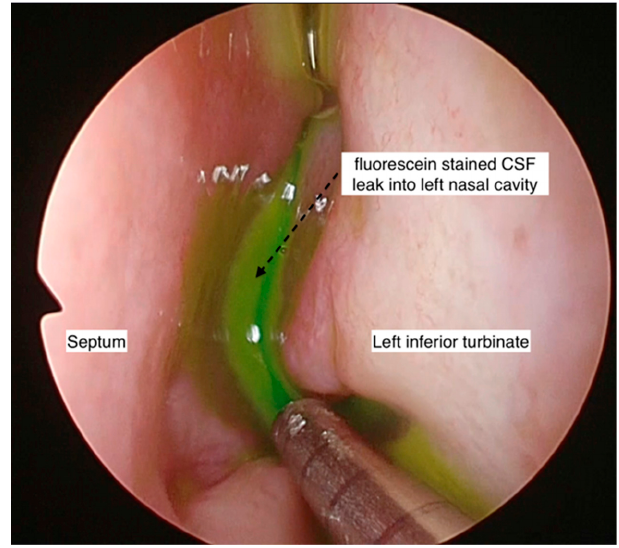
Figure 2. Endoscopic photo of left nasal cavity showing fluorescein-stained CSF within the nasal cavity. This aids in the identification of the exact site of the CSF leak or if there are multiple sites of leak.